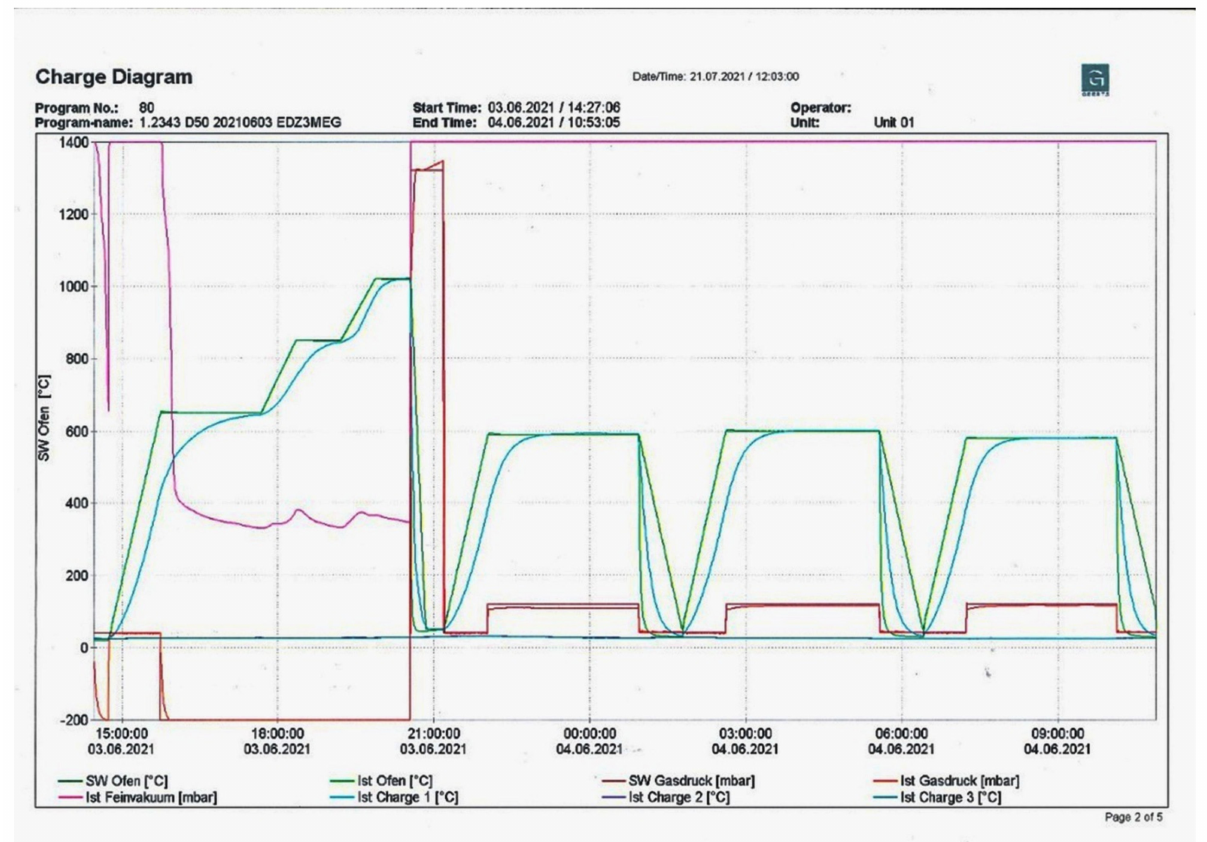
Figure 2. The heat-treatment process. (green line—programmed and measured temperature in the furnace, blue line— temperature at the middle of the sample, purple line—vacuum, red line—pressure of N 2